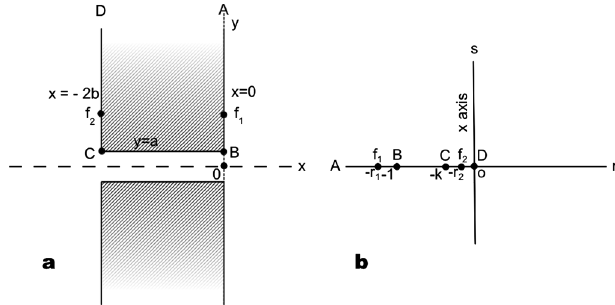
FIG. 2. Conformal mapping of double-sided pole pieces. (a) Pole pieces in the z plane. (b) Image of pole pieces and x axis in t plane. f 1 and f 2 indicate the positions of current filaments on the pole